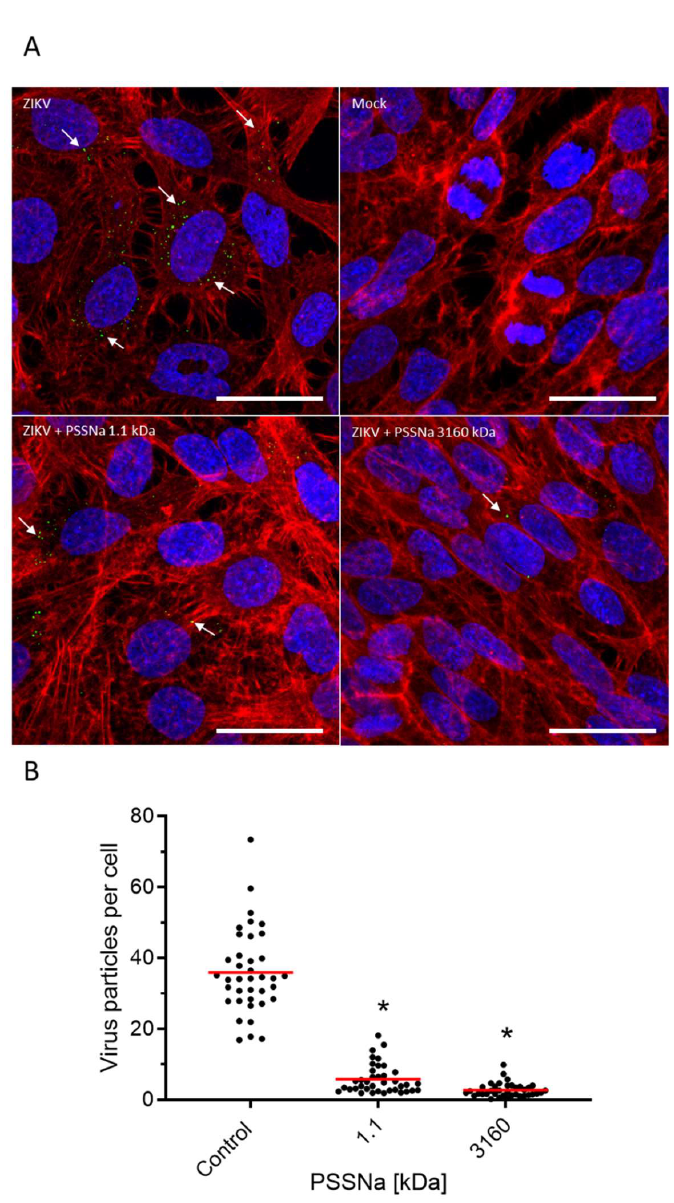
Figure 7. PSSNa blocks the attachment of ZIKV to host cells. Vero cells were inoculated with ZIKV H/PF/2013 (TCID50 = 10,000/mL) in the presence of 250 µg/mL PSSNa of 1.1 or 3160 kDa or control buffer. Cells were incubated at 4 °C for 2 h, fixed, and confocal images were collected. ( A ) Cell nuclei are denoted in blue, β-actin in red, and ZIKV E protein is denoted in green (indicated by arrows). Scale bar = 100 µm. ( B ) Confocal microscopy analysis of the number of particles on the surface of cells treated with PSSNa. The number of particles and the number of cells was assessed using ImageJ Fiji 3D Objects Counter tool. Each set shows data from a minimum of 45 fields of view registered from 7 different samples prepared in three independent experiments. An asterisk ( p < 0.05) indicates values that are significantly different from the control.